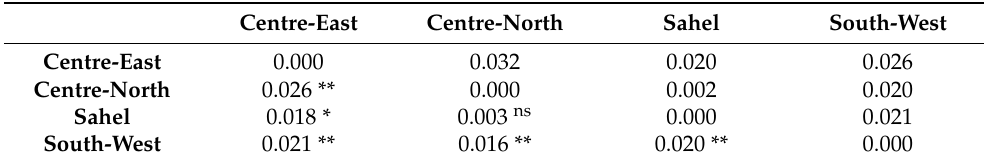
Table 3. Population pairwise F ST (below the diagonal) and Nei’s unbiased genetic distance (above the diagonal) in local chickens from the Centre-East (Konde ecotype), Centre-North, Sahel and South-West regions of Burkina Faso. Centre-East Centre-North Sahel South-West Centre-East 0.000